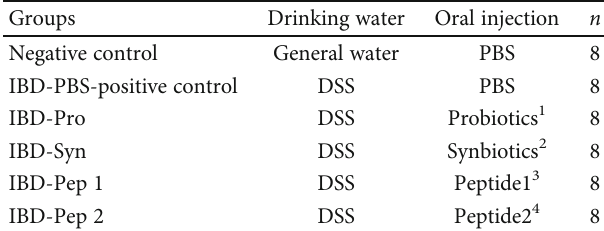
Table 1: Experimental